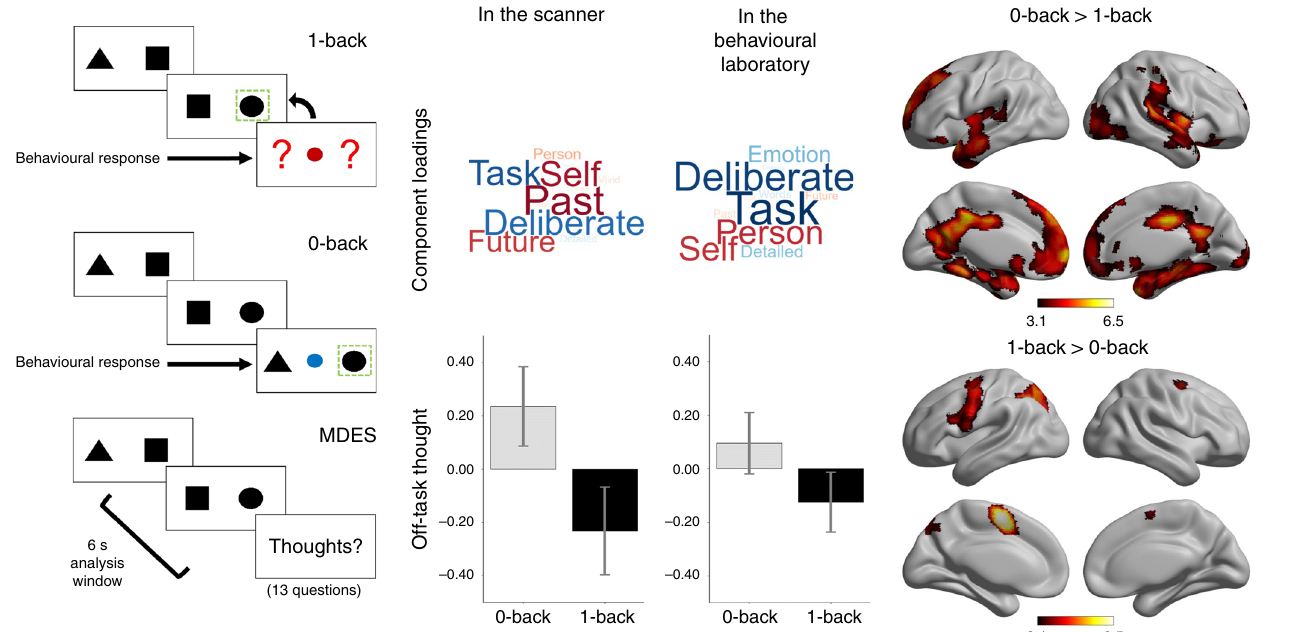
Fig. 1 0-back and 1-back tasks vary in their need for external attention in the scanner and the laboratory. Participants performed alternating blocks of two tasks (left). In the 0-back task, off-task thinking was increased (middle) in both the laboratory and scanner. The application of principal component analysis to MDES data identi fi es dimensions of thought by grouping questions that capture shared variance. One component identi fi ed in this manner captures a dimension that varies from a focus on the task to thoughts about the self and other and with an episodic focus, corresponding to one common de fi nition of off-task mind-wandering 70 . The loadings on this component are presented in the form of wordclouds. Words in a larger font indicates items with a greater loading on the dimension and the colour describes the direction of this loading (red: positive, blue: negative). The average score for this off-task dimension of thought in each task is shown in the bar graphs in which the error bars indicate the 95% con fi dence intervals of the mean. Contrasts comparing neural activity across these conditions showed increased activity in default mode network regions during the 0-back, and left lateralised frontal and parietal regions during the 1-back (right). Task maps are corrected with a cluster-forming threshold of Z > 3.1, at a family-wise error rate of p <